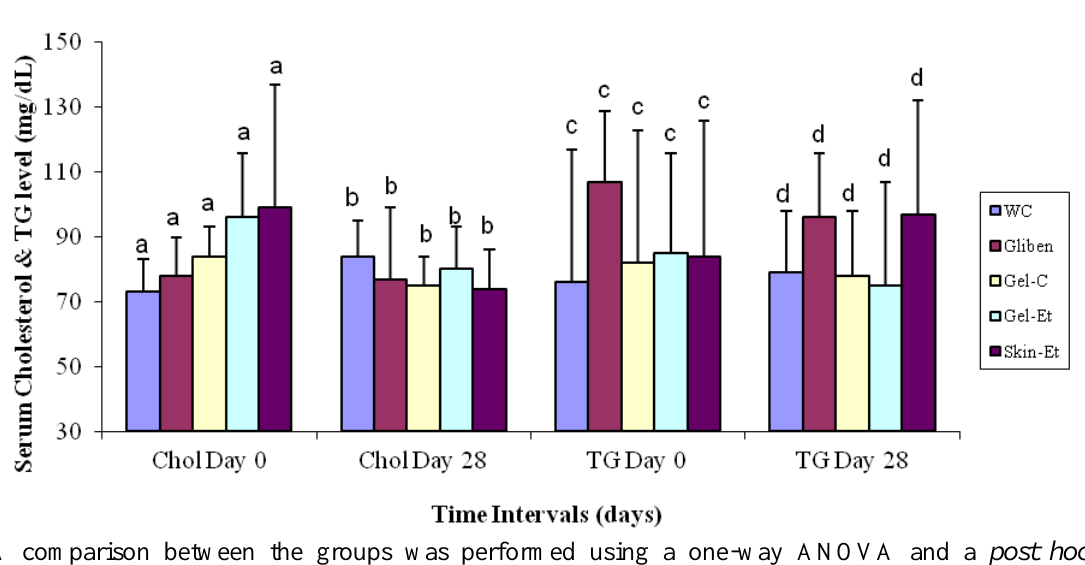
Figure 2. Effects of different treatments on the serum lipid profile of type 2 diabetic model rats. Chol = Cholesterol; TG = Triglycerides.